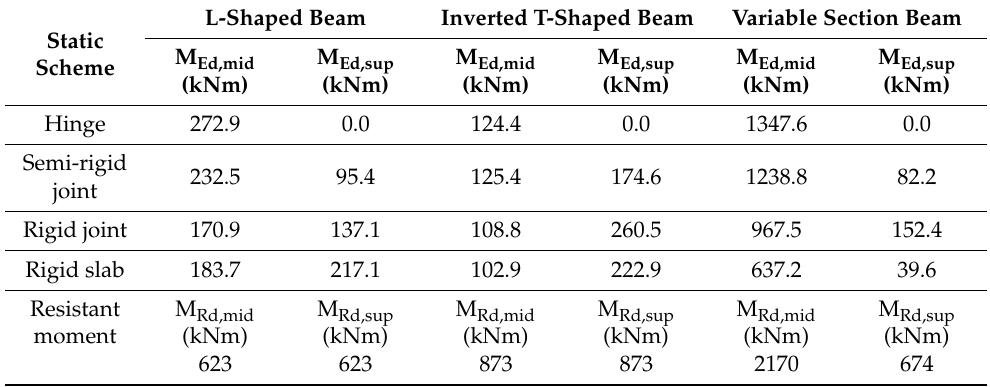
Table 4. Bending moment checks of